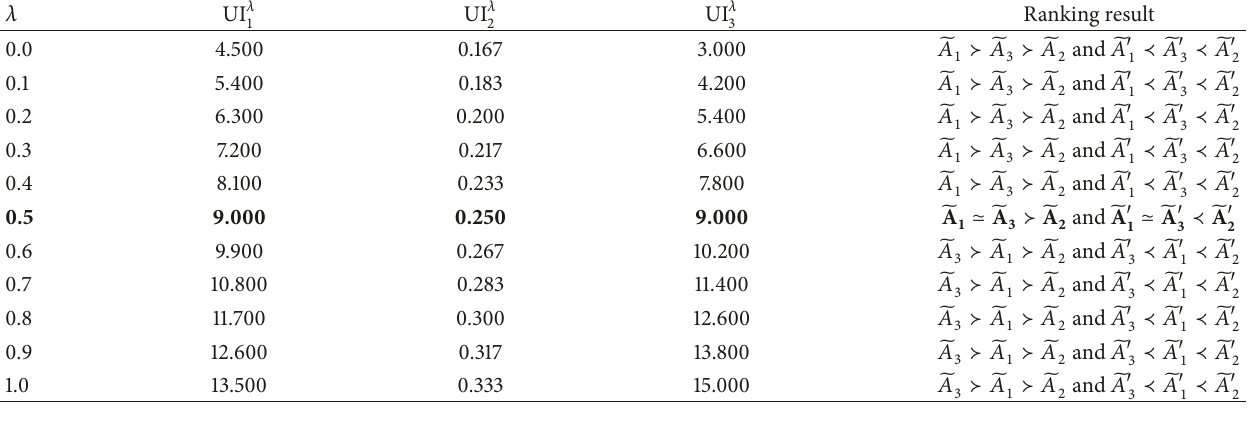
Table 6: Ranking results of the three fuzzy numbers in Example 19.